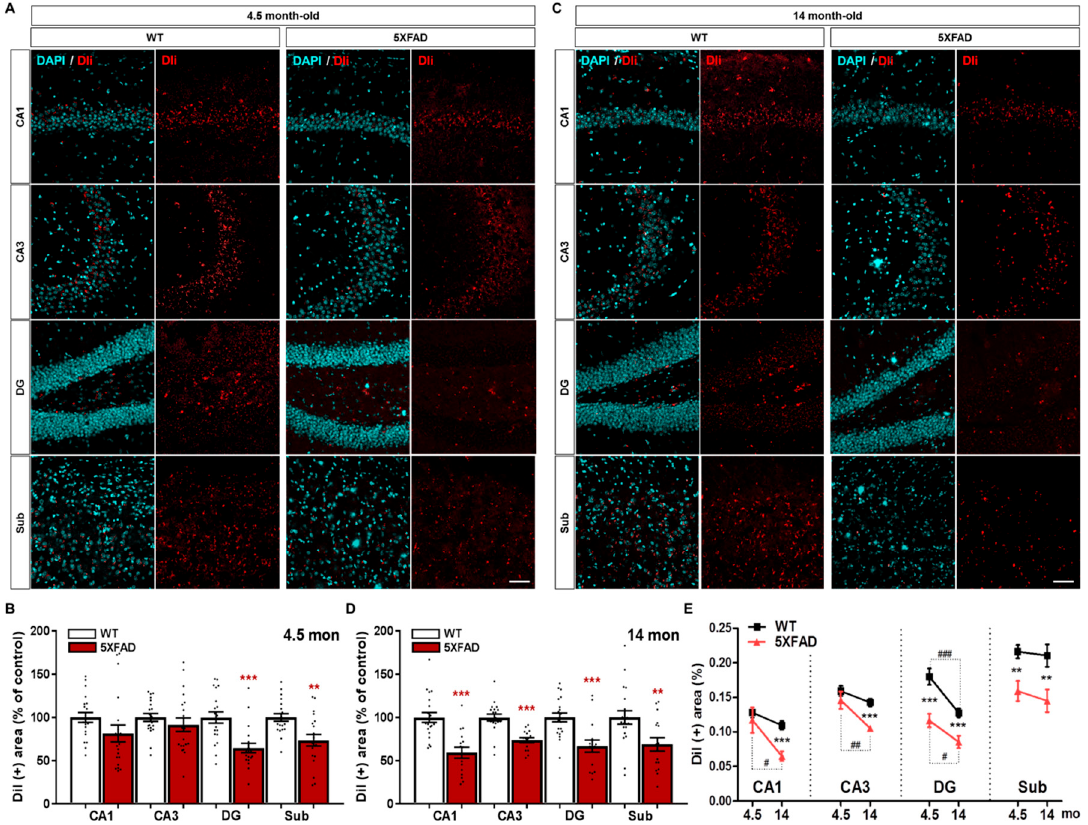
Figure 5. Degeneration of the hippocampo-septal pathway in WT and 5XFAD mice. ( A ) Representative images of DiI-containing somata in the CA1, CA3, DG, and Sub of WT and 5XFAD mice at the age of 4.5 months. ( B ) Quantification of the DiI-positive area of the hippocampal formation of 4.5-month-old WT and 5XFAD mice. ( C ) Representative images of DiI-containing somata in the CA1, CA3, DG, and Sub of WT and 5XFAD mice at the age of 14 months. ( D ) Quantification of the DiI-positive area of the hippocampal formation of 14-month-old WT and 5XFAD mice. ( E ) Comparison of DiI-positive area in the hippocampo-septal degeneration by aging and AD progression. Scale bar = 100 μ m. ** p < 0.01, *** p < 0.001 indicate significant differences between the WT and 5XFAD mice of the same age. # p < 0.05 , ## p < 0.01, and ### p < 0.001 indicate significant differences between the different ages in the same group (n = 20–35 images/group).